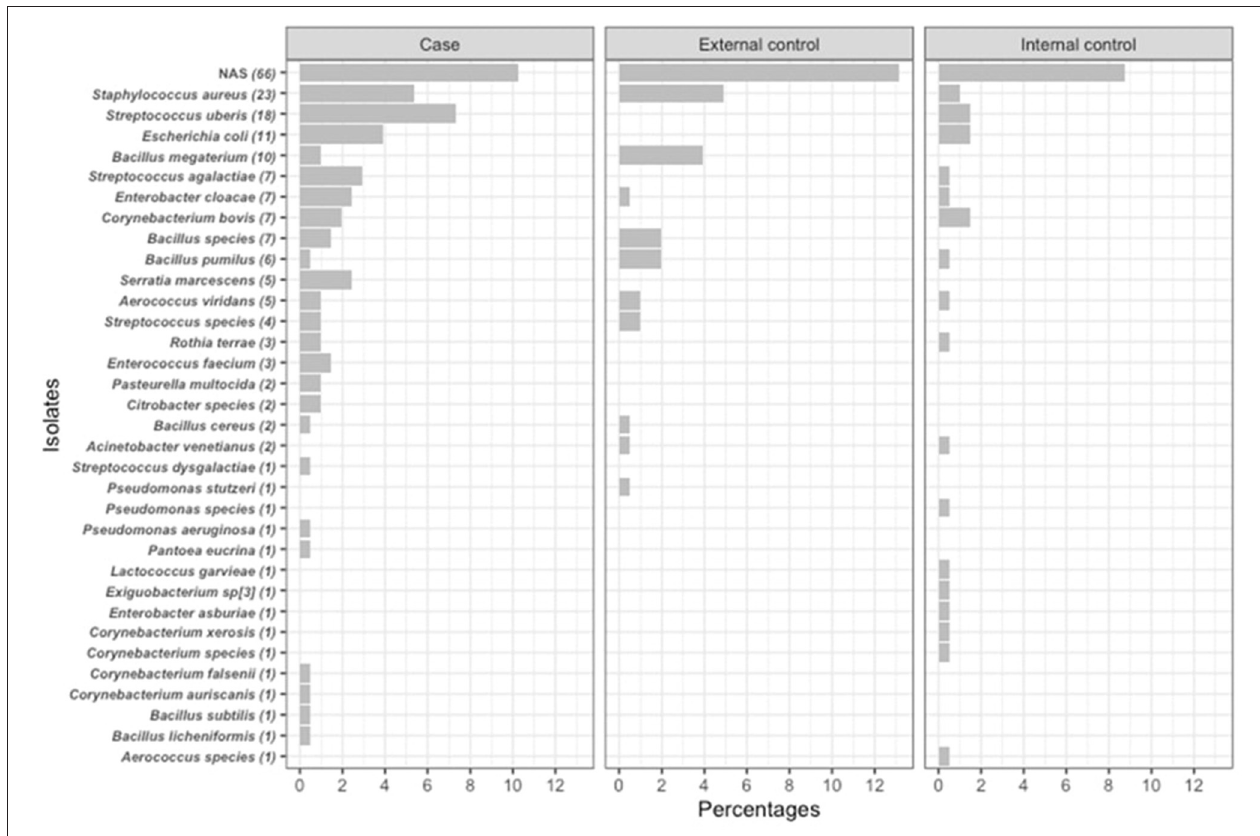
FIGURE 2 | Counts and percentages of isolates ( n = 205) cultured from quarter-level milk samples ( n = 419) obtained from mastitis cases ( n = 102), external ( n = 61) and internal ( n = 42) controls. Milk samples were obtained from dairy cattle originating from 18 dairy herds in Northern Queensland, Southeast Queensland and Victoria between March and June